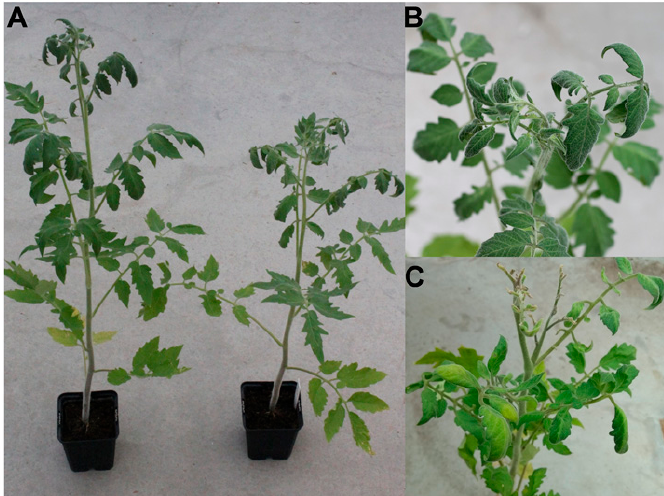
Figure 4. ( A ) Symptoms associated with ToTLV infection in tomato plants (cv. Moneymayker) after agroinoculation. Mock-inoculated (left) and ToTLV-inoculated (right) plants at four weeks post inoculation (wpi). ( B ) Twisted leaf symptoms observed in ToTLV-inoculated plants. ( C ) Severe symptoms (e.g., size reduction of young leaves, chlorosis, and leaf deformation) observed in tomato plants after eight wpi.